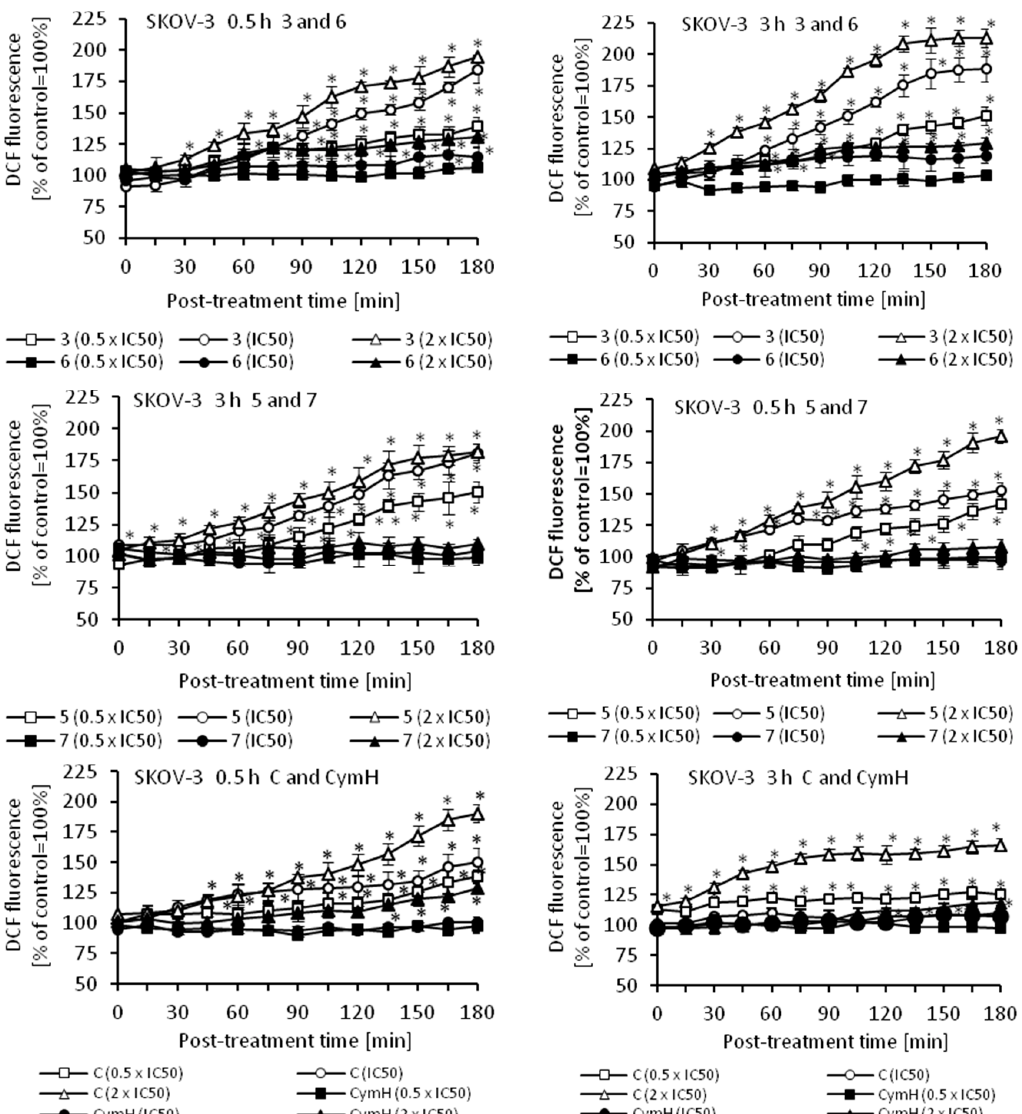
Figure 8. Changes in the relative level of ROS in SKOV-3 cells treated for 0.5 or 3 h with different concentrations (0.5 × IC 50 , IC 50 , and 2 × IC 50 ) of cymantrenes 1 , 2 , 3 , 5 , 6 , 7 , C, and CymH when compared with the ROS amount in untreated controls (100%). The kinetics of ROS formation was chased over 0–180 min time period after the treatment. The results are the means ± SD of 3 independent experiments, each performed in at least six repeats; * p < 0.05 as compared to untreated SKOV-3 cells (control).